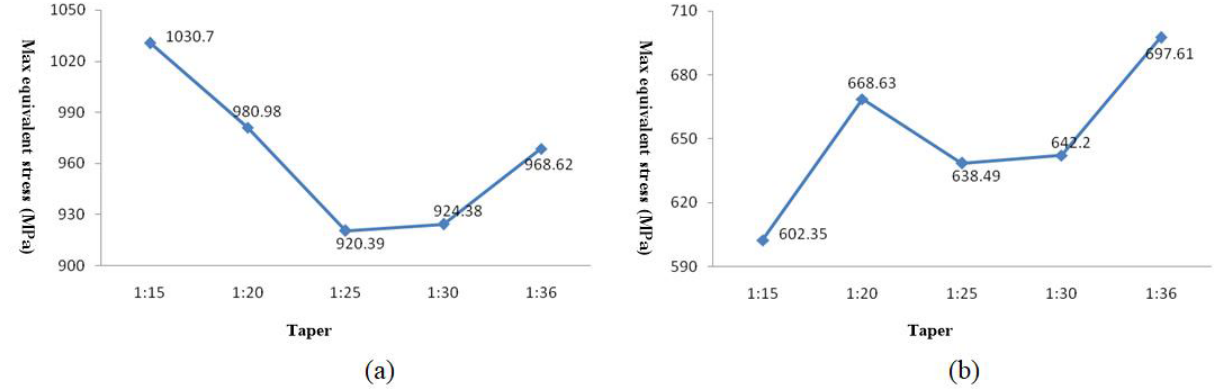
Figure 13. (a) Relationship between thread taper and the maximum equivalent stress of tube body; (b) relationship between thread taper and the maximum equivalent stress of joint.